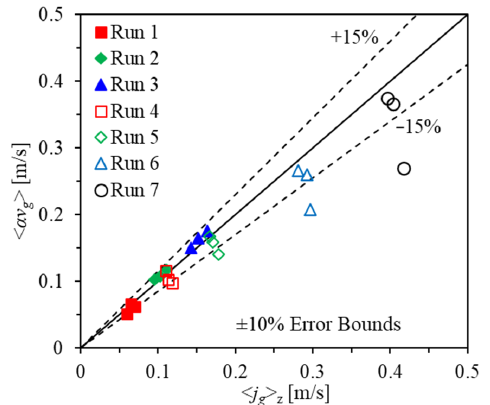
Figure 4. Benchmark of the conductivity probe measurements.